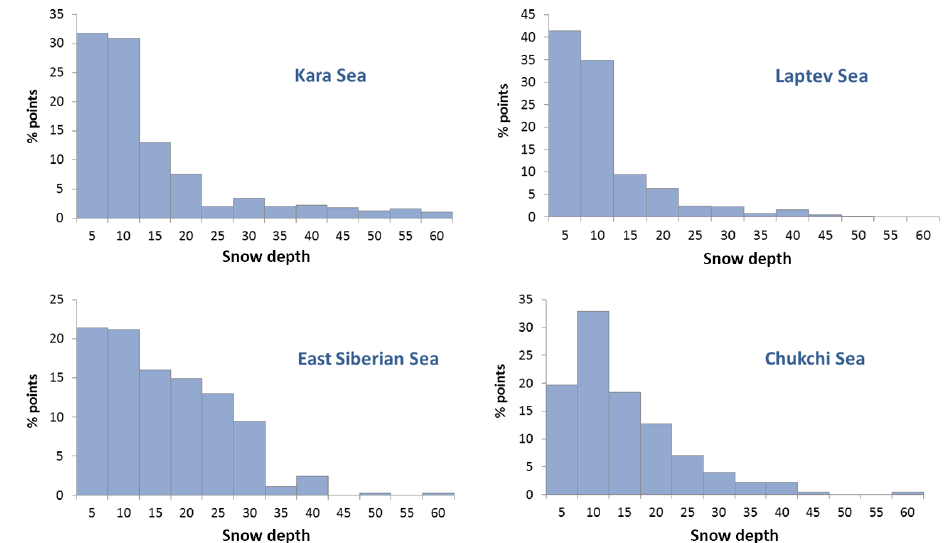
Figure 6. Distribution of snow depth on the level ice in the marginal